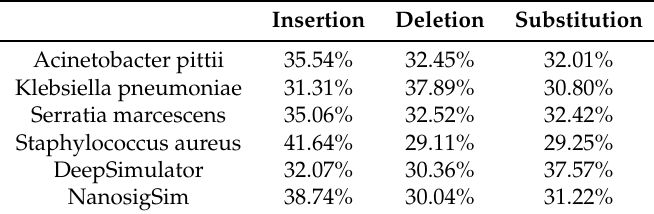
Table 2. The error distribution of different types of reads, tested on the four real reads and the two simulated reads, which are basecalled using Guppy.